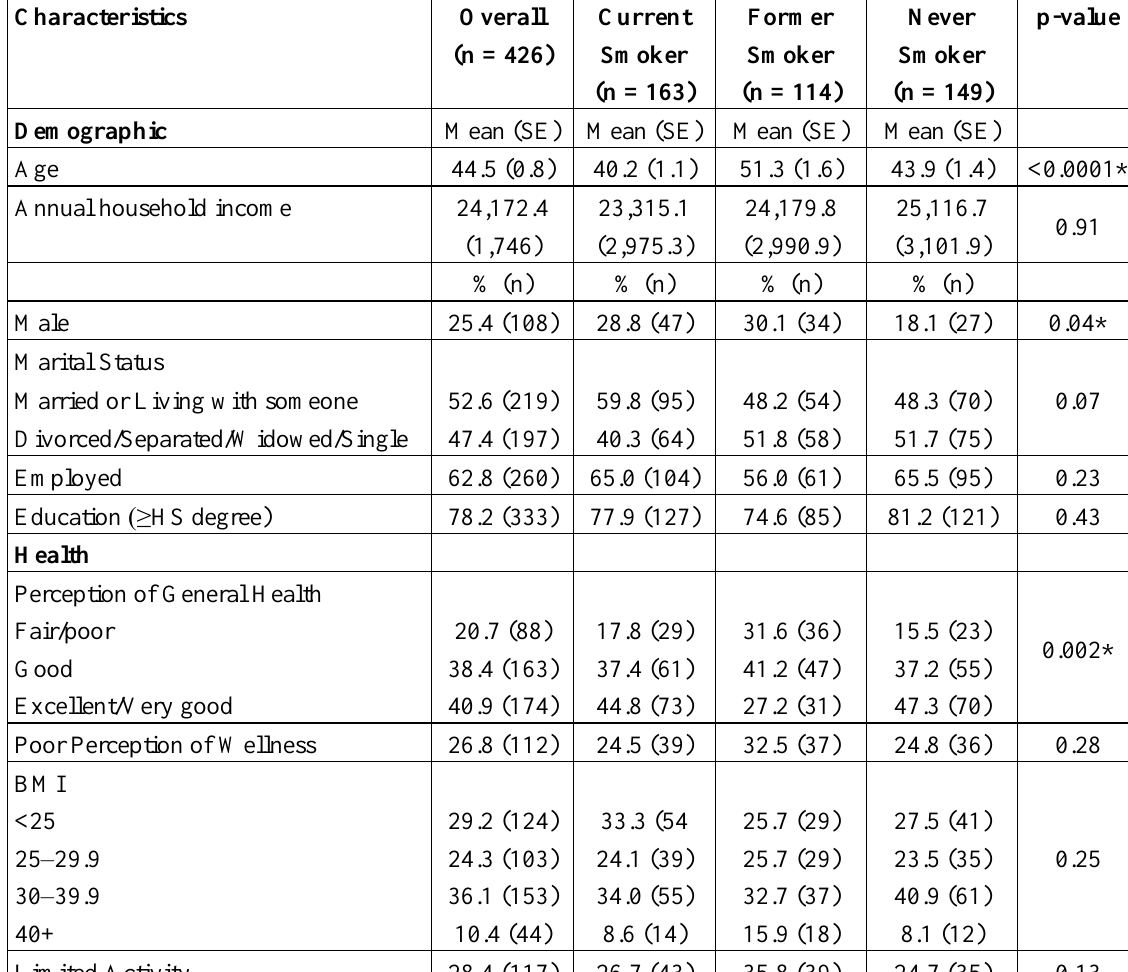
Table 1. Characteristics of American Indian Adults by Smoking Status (Current, Former and Never).